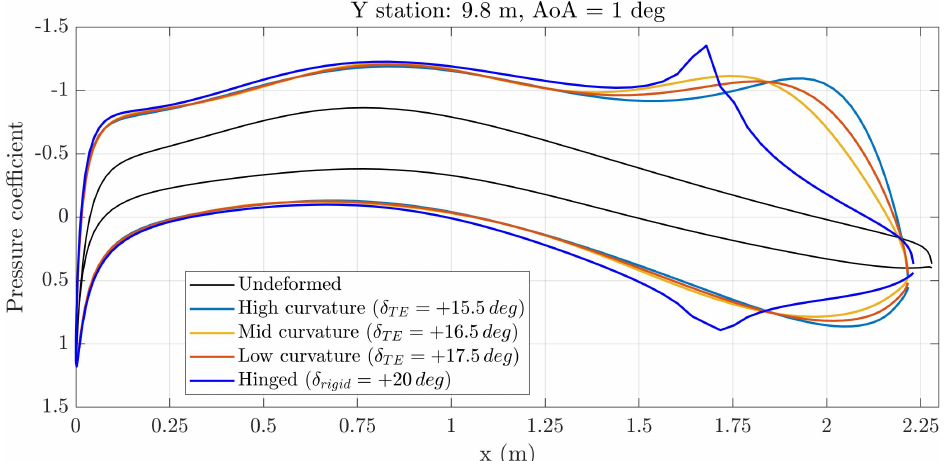
Figure 17. Comparison between pressure coefficient distributions for the downward deflection ( AoA = 1